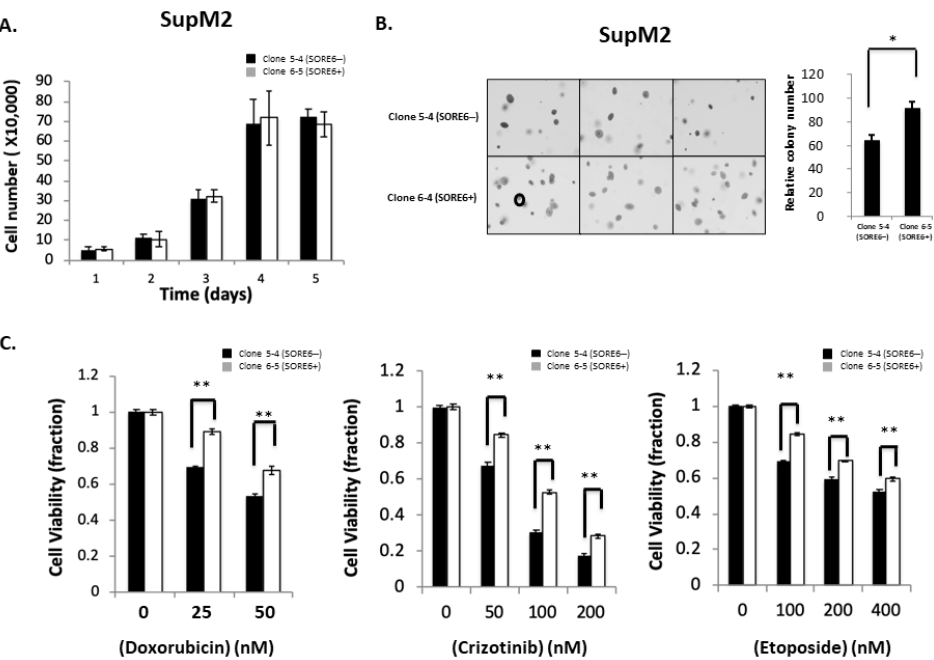
Figure 4. Cell growth, colony formation, and response to therapeutic agents in SORE6 − and SORE6+ clones. ( A ) Cell growth of 5-4 (SupM2 SORE6 − ) and 6-5 (SupM2 SORE6+) clones over the course of 5 days. ( B ) Soft agar colony formation of SORE6 − and SORE6+ subsets in SupM2 clones for 10 days. The circle on the bottom-left panel marks the cutoff for a colony to be counted. Triplicate experiments were performed. Experiments were repeated in two single-cell clones. The right panel showed the relative colony numbers in SupM2 cells. Results are mean ± SEM, * p < 0.05. ( C ). SupM2 SORE6 - and SORE6 + cells after treatment with doxorubicin, crizotinib, and etoposide at the indicated concentrations for 48 h at 5% FBS. Results shown are representative of three independent experiments. ** p < 0.01.